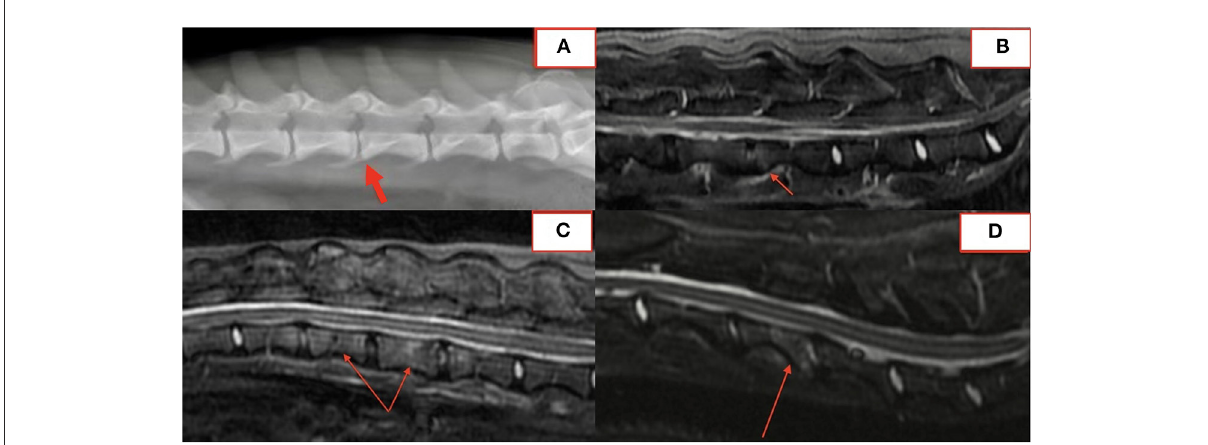
FIGURE3 Lateral radiograph (A) and STIR MRI (B) demonstrating vertebral physitis and osteomyelitis without obvious discitis at L4-5. Lateral STIR imaging at T11-L1 (C) and C4-5 (D) from two dogs with osteomyelitis without significant intervertebral disc involvement.